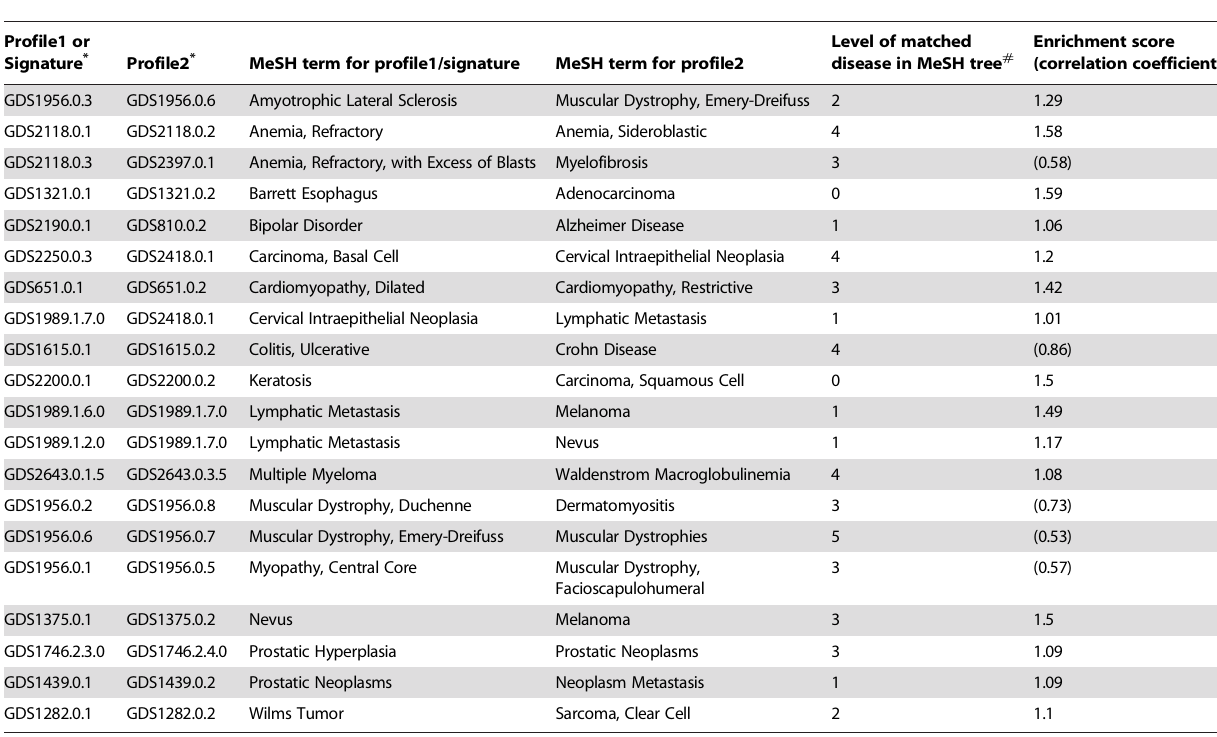
Table 1. A manual selection of disease connections and their mapping on MeSH disease